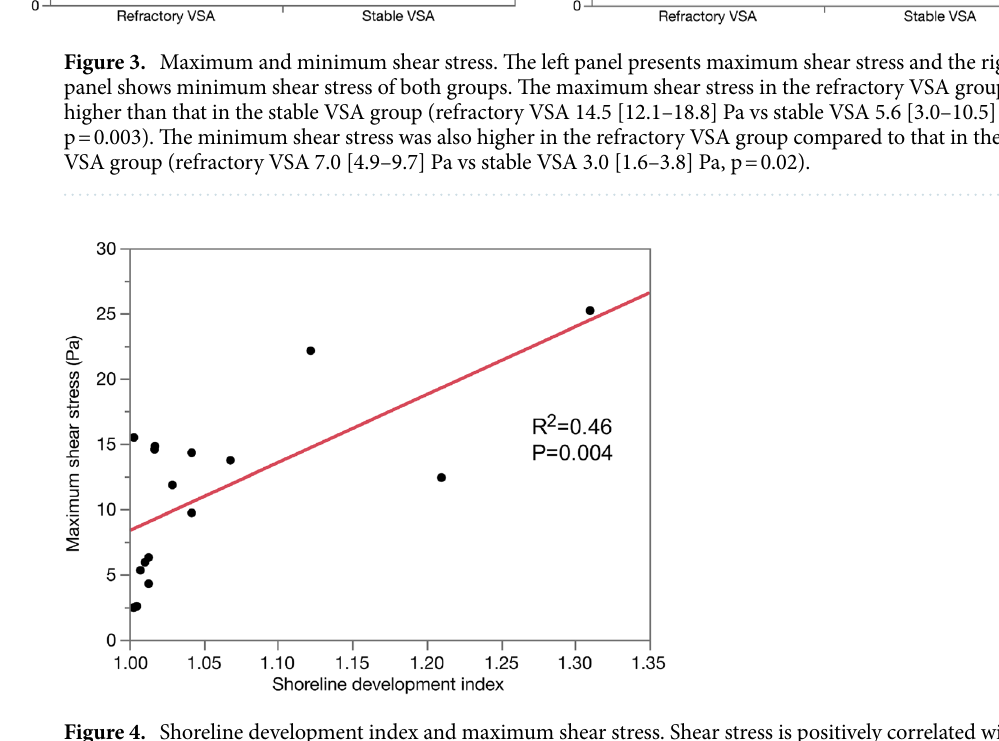
Figure 4. Shoreline development index and maximum shear stress. Shear stress is positively correlated with the shoreline development index (R 2 = 0.46, P = 0.004). Complexity of lumen circumference increases the shear stress in